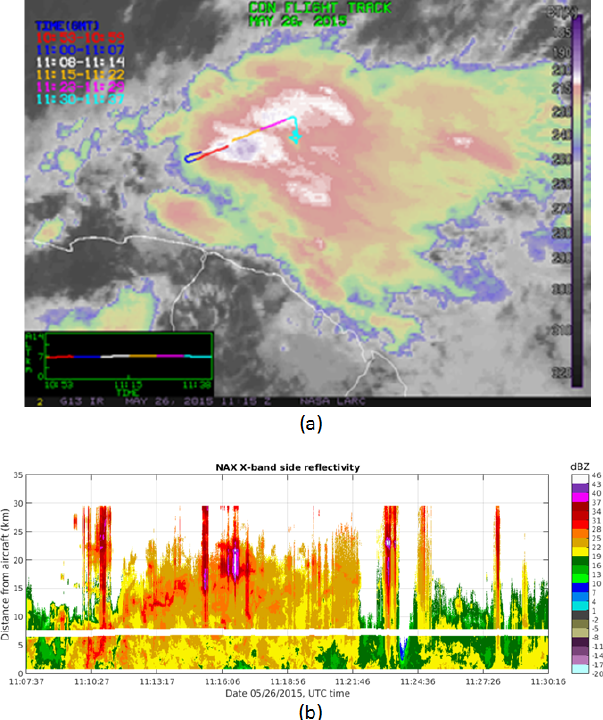
Figure 4. Panel (a) shows IR GOES-13 image with the overlaid seg- ments of the Convair CV-580 flight track on 26 May 2015. Differ- ent time segments of the flight track are shown by different colours. Panel (b) shows X-band side reflectivity from a period of 11:07– 11:30UTC corresponding to white, yellow, and purple segments in (a) . A break line at around 7.1km is the location of contaminating ground clutter via the side antenna’s side lobe (Sect. 3.1), which was filtered